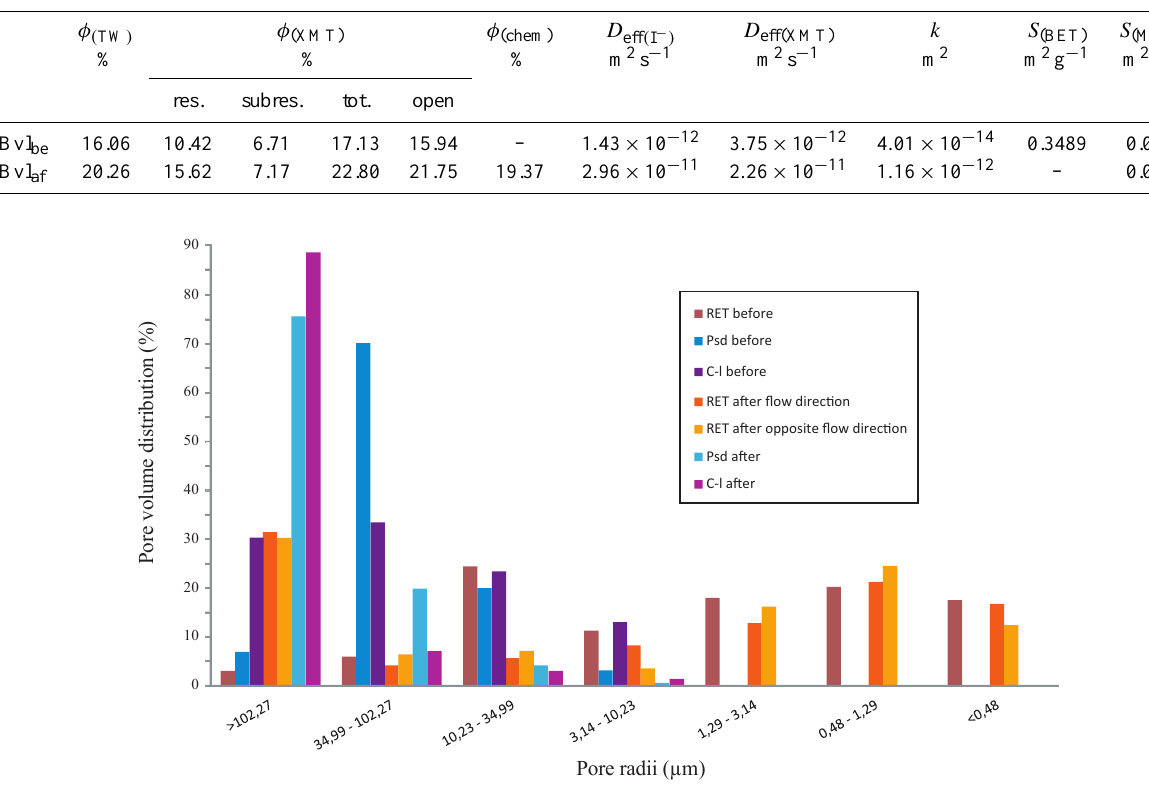
Figure 4. Pore volume content for different pore-size diameters before and after the dissolution experiment. The data have been extracted from the Psd and C-l numerical measurements and RET laboratory acquisition. For the latter, the distributions after dissolution were obtained both by draining in the flow direction and in the opposite direction.